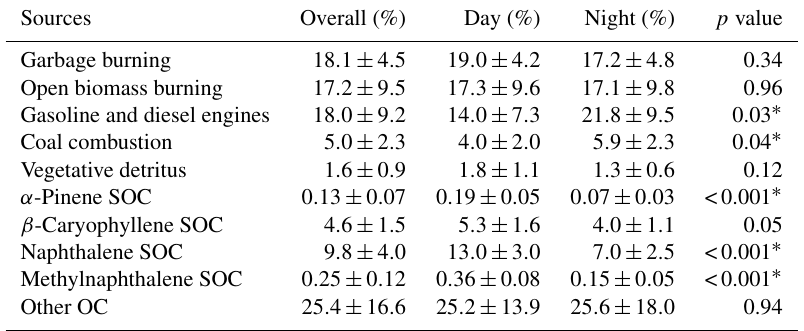
Table 6. Relative primary and secondary source contributions to PM 2 . 5 OC during day and night periods in the Kathmandu Valley. Source contributions during day and night periods were compared and p values<0.05 (marked by ∗ ) indicate significant differences at the 95% confidence